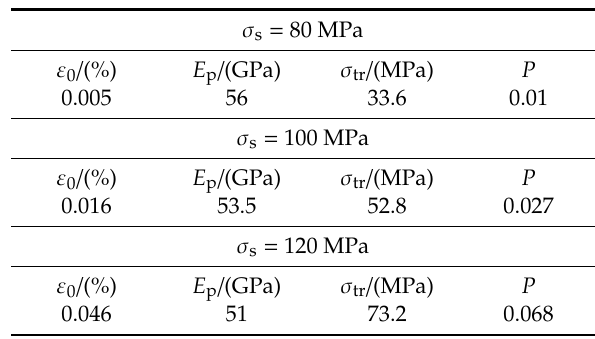
Figure 16. ( a ) The tensile stress–strain curves; ( b ) the tangent modulus versus strain curves; ( c ) the interface debonding fraction versus stress curves; and ( d ) the broken fibers fraction versus stress curves of 2D SiC/SiC composite for conditions without stochastic loading and with stochastic loading of σ s = 80, 100 and 120 MPa. Table 9. The tensile stress–strain curve, tangent modulus, interface debonding fraction and broken fiber fraction of 2D SiC / SiC composite subjected to stochastic loading of σ s = 80, 100 and 120 MPa.